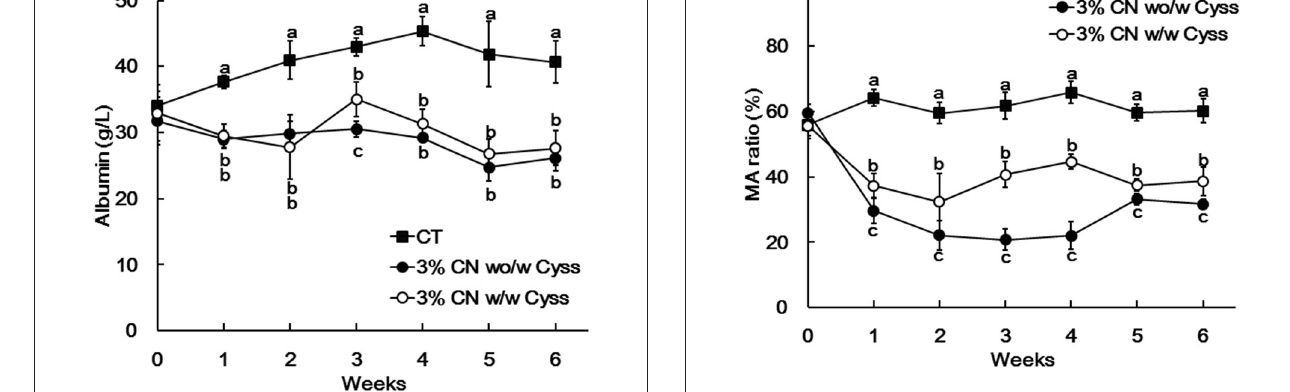
FIGURE 5 | Plasma albumin levels in Experiment 2. The levels of albumin were measured for plasma samples obtained during the experimental period. Data are shown as means ± SD ( n = 6); values with different letters are significantly different at each time point ( P < 0.05). CN, CT, and Cyss denote casein, control, and cystine, respectively.